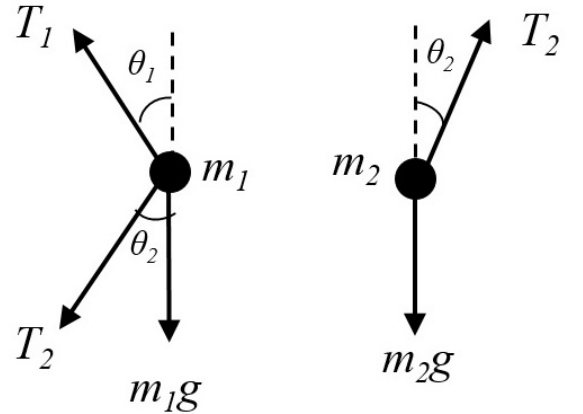
Figure 2. Forces in the double pendulum